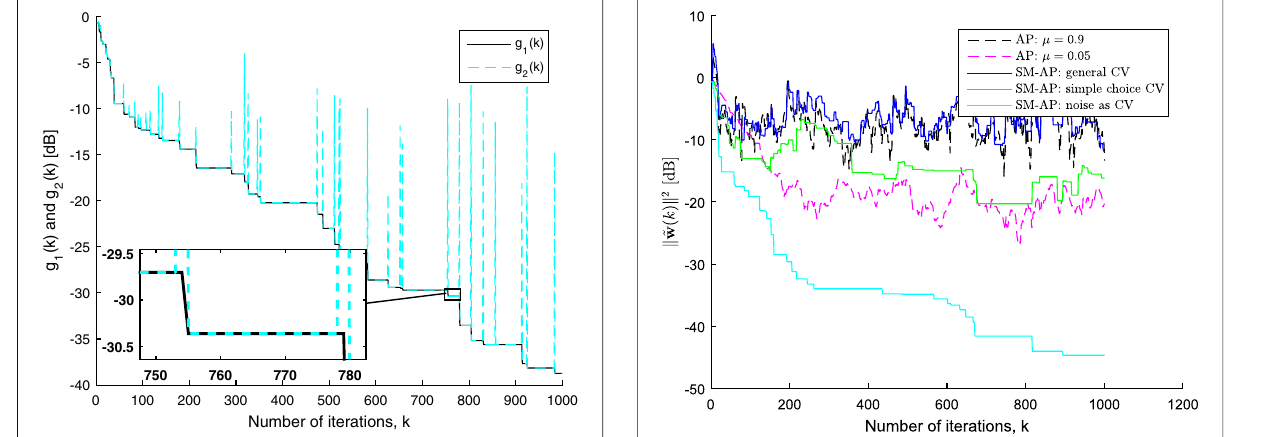
Fig. 7 (cid:3) ˜ w ( k ) (cid:3) 2 (cid:2) (cid:3) w ( k ) − w o (cid:3) 2 for the AP and the SM-AP algorithms (cid:21) (cid:22) (cid:3) ˜ w ( k ) (cid:3) 2 of , i.e., this sequence increases and decreases